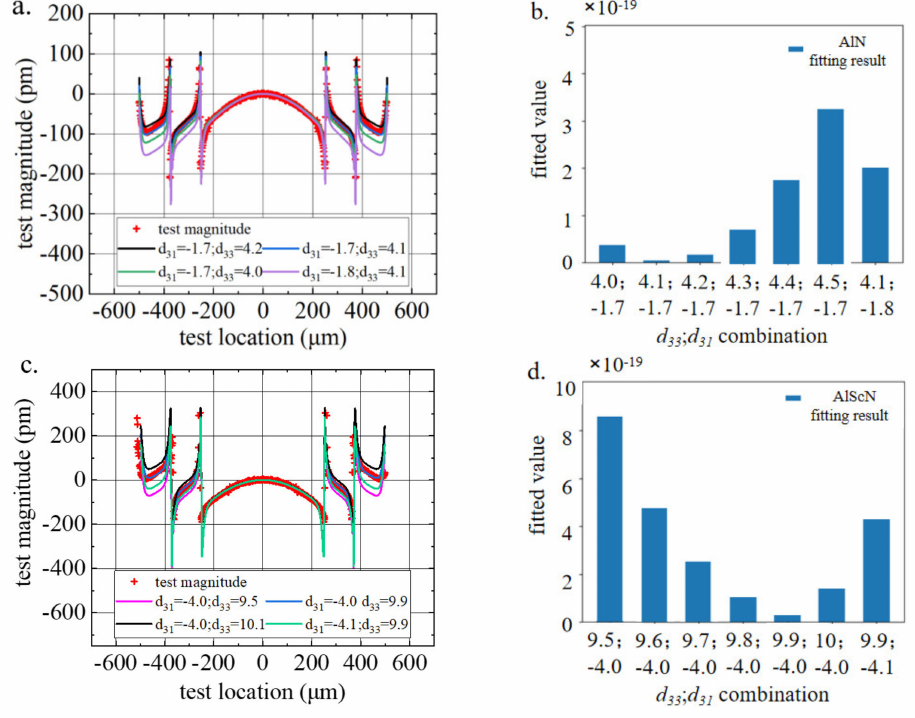
Figure 5. ( a , b ) AlN and ( c , d ) AlScN test and simulation data fitting